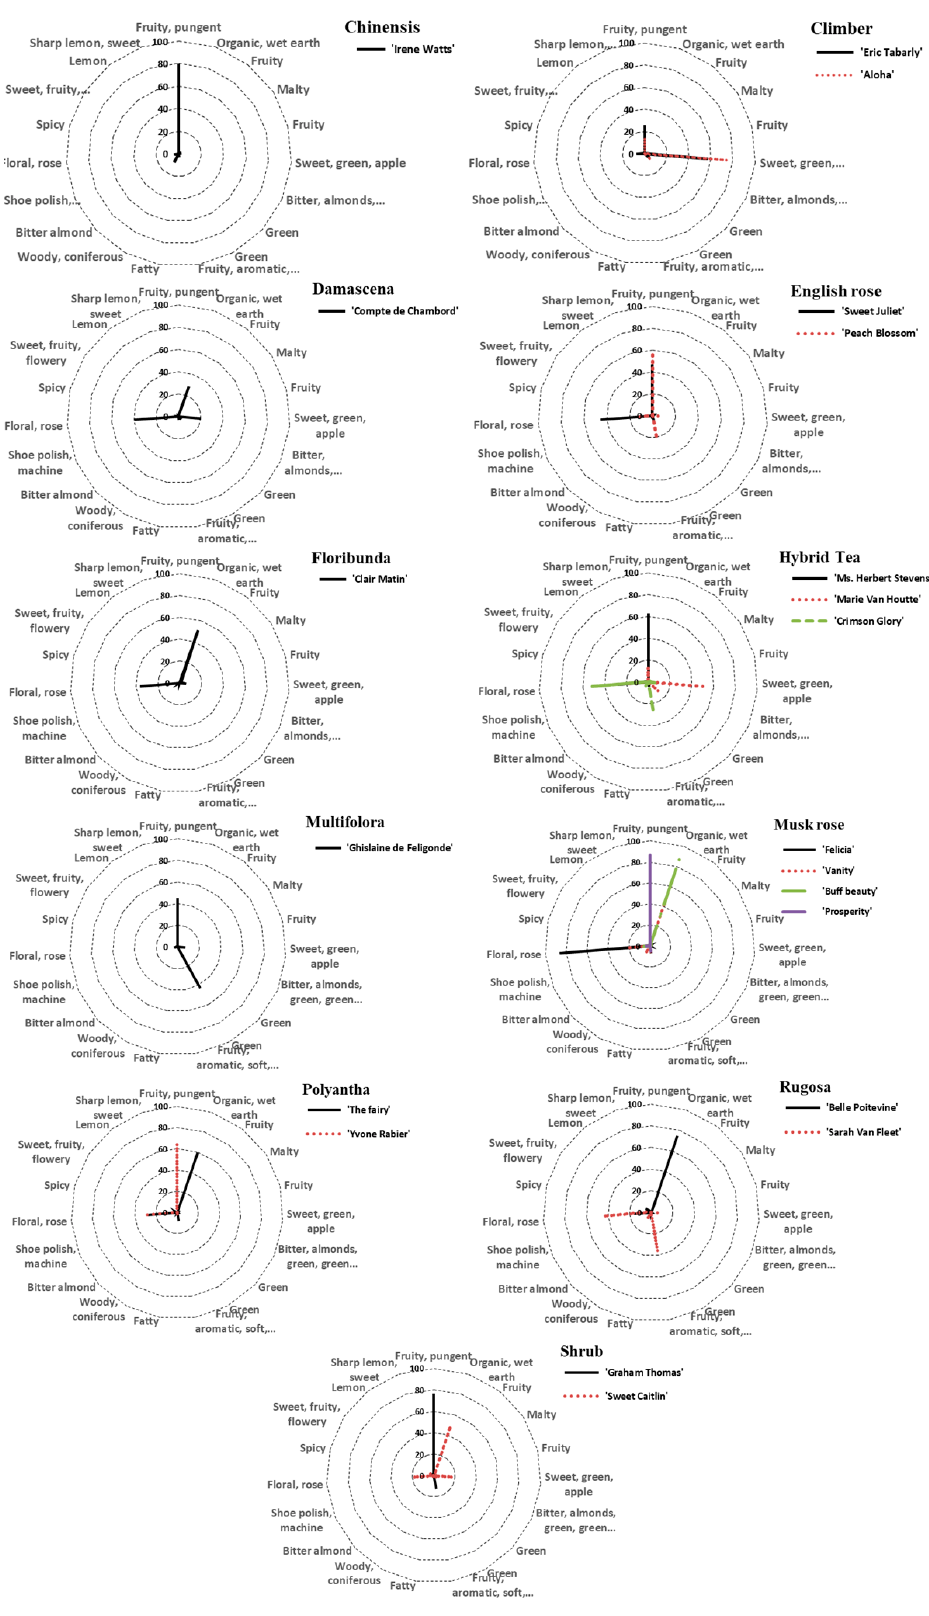
Figure 2. Radar charts showing the percentage (0–100%) of each odour description (see Table 2) within the airless headspace of the petals of the 21 studied garden rose genotypes. Cultivars were grouped in horticultural classes, as indicated in Table